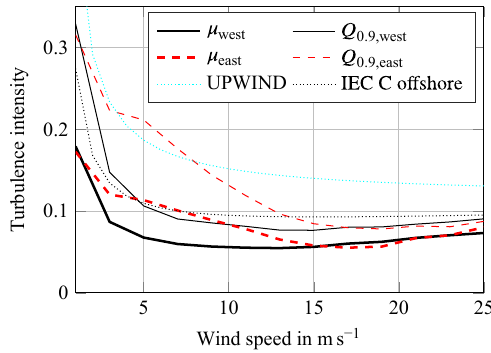
Figure 9. Shadow effects on the turbulence intensity for FINO1 and free stream (western) and wake (eastern)